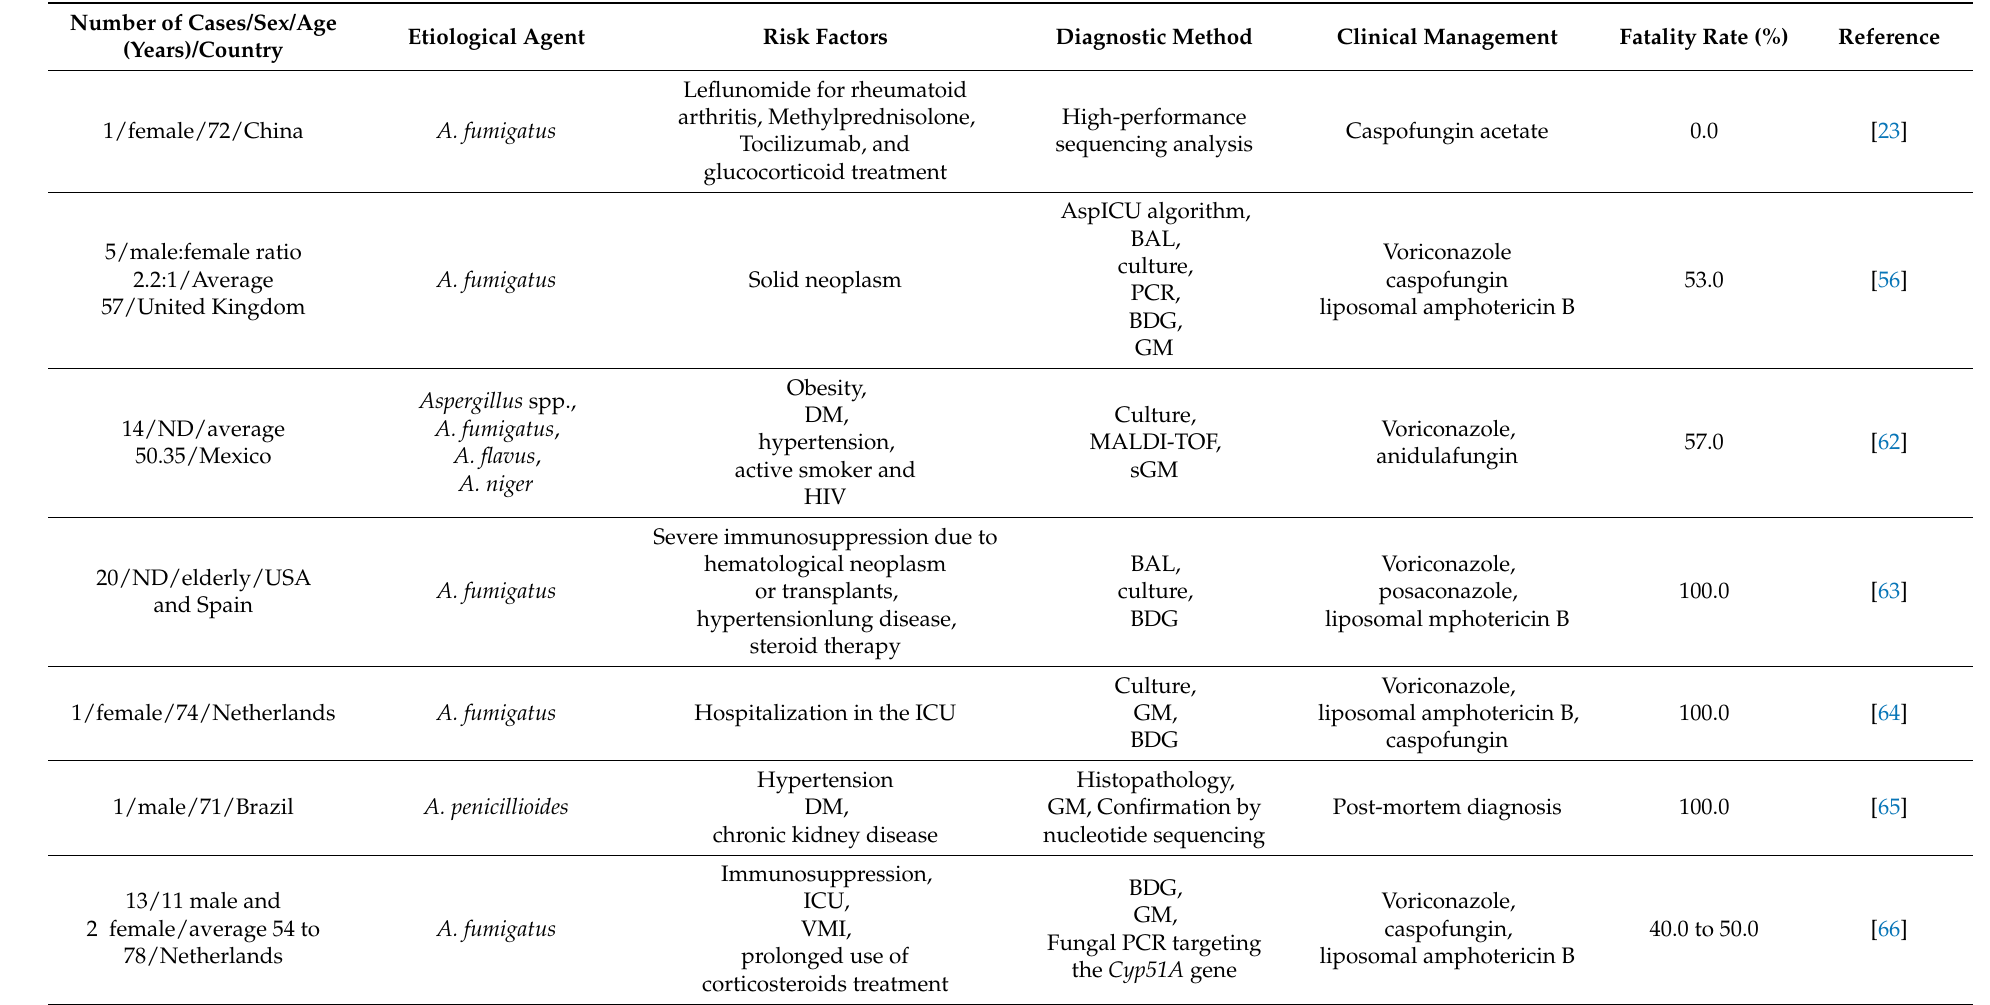
Table 3. Cases of COVID-19 and aspergillosis